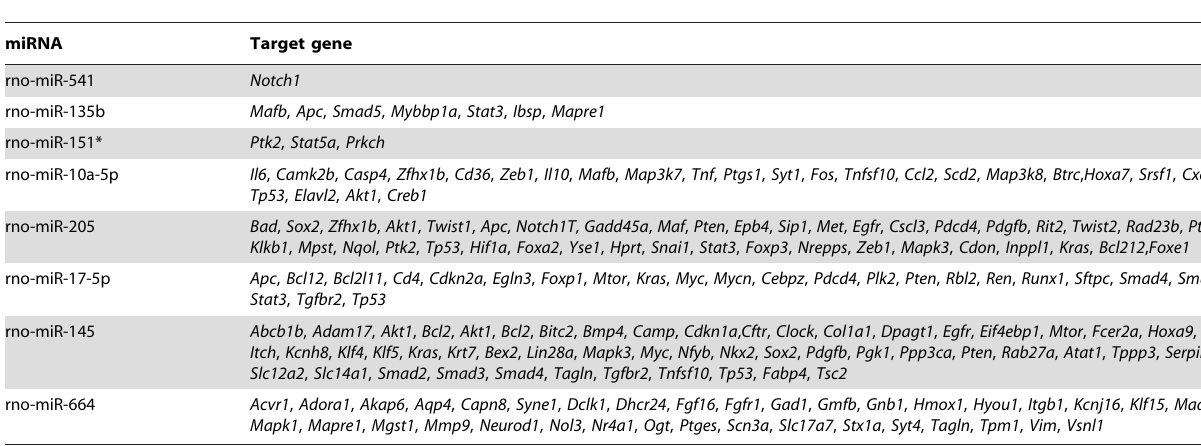
Table 3. Validated targeted genes for defferentially-expressed miRNAs.